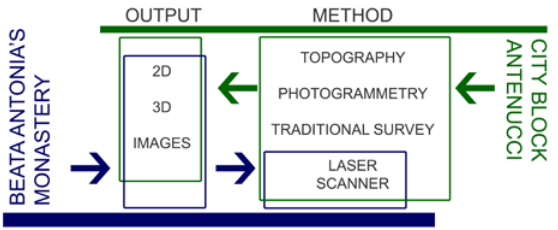
Figure 16. Methodological workflow of the two case